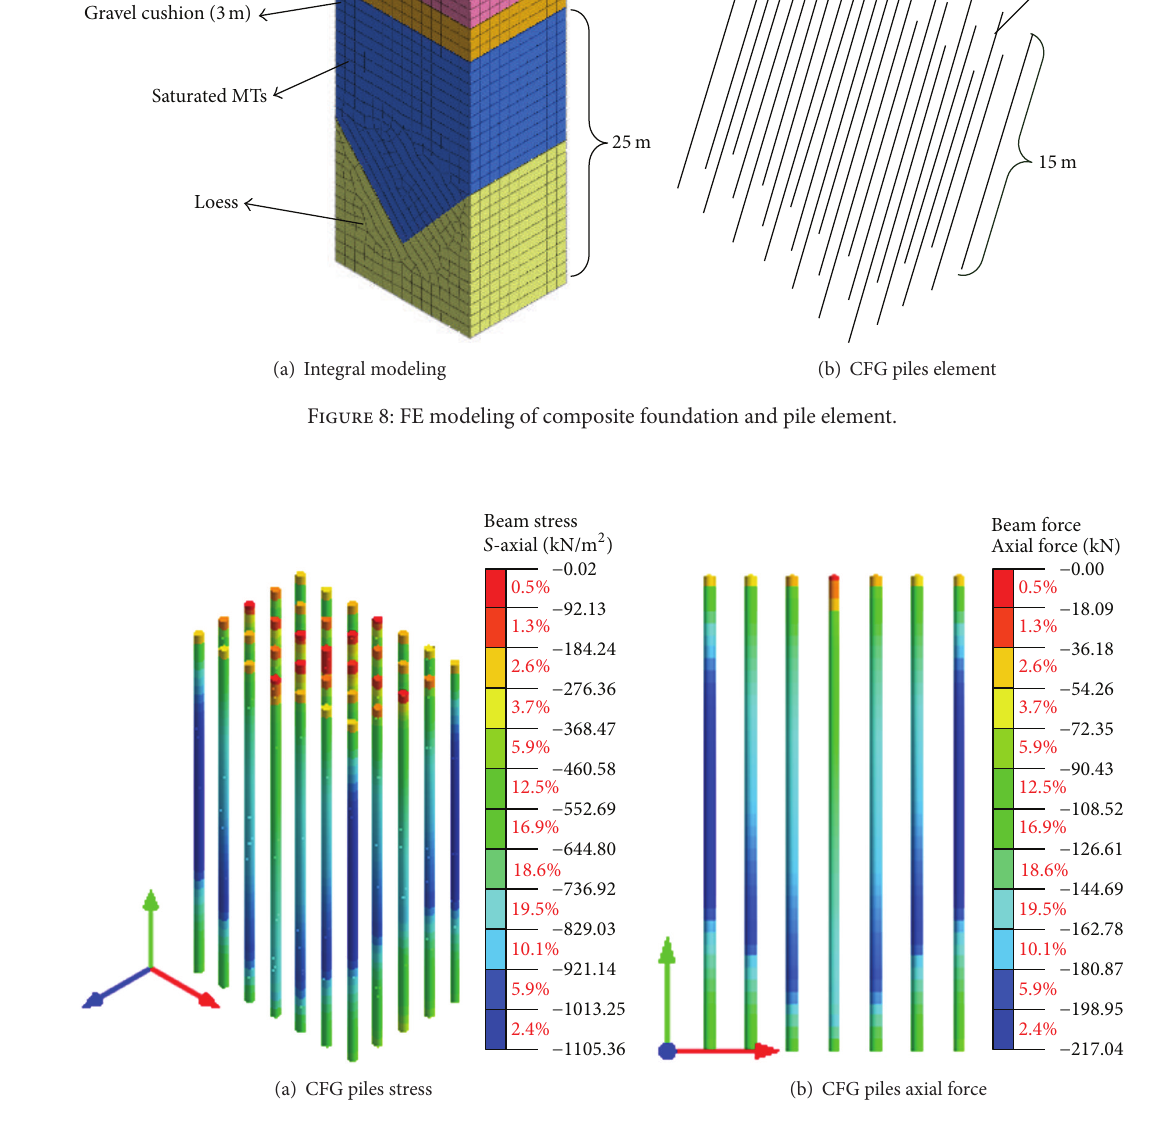
Figure 9: FEM results of CFG piles stress and axial force under the loading of 150kPa.